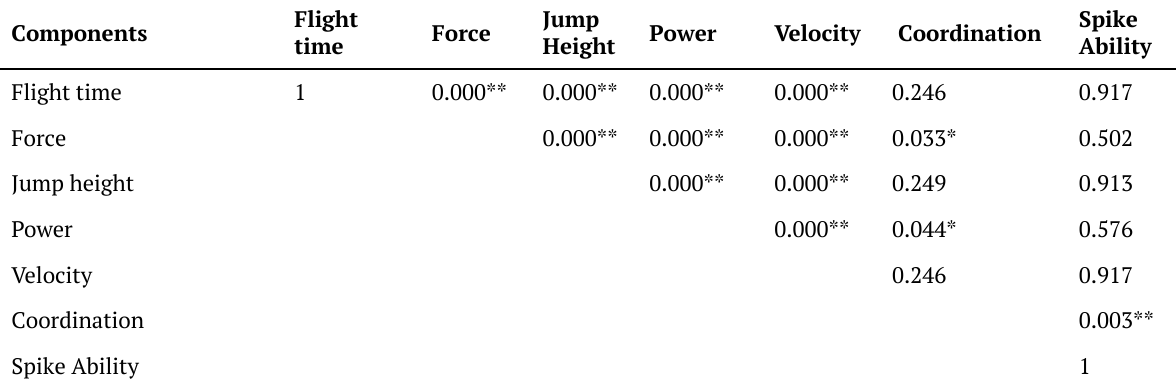
Table 4. Comparison of measurement component between men and women